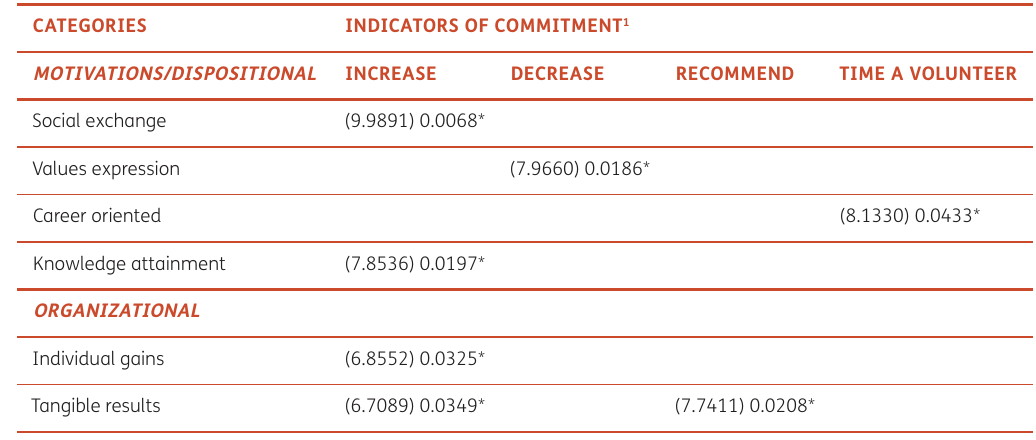
Table 9 Nonparametric results for Indicators of Commitment and organizational and dispositional variables (H3 and